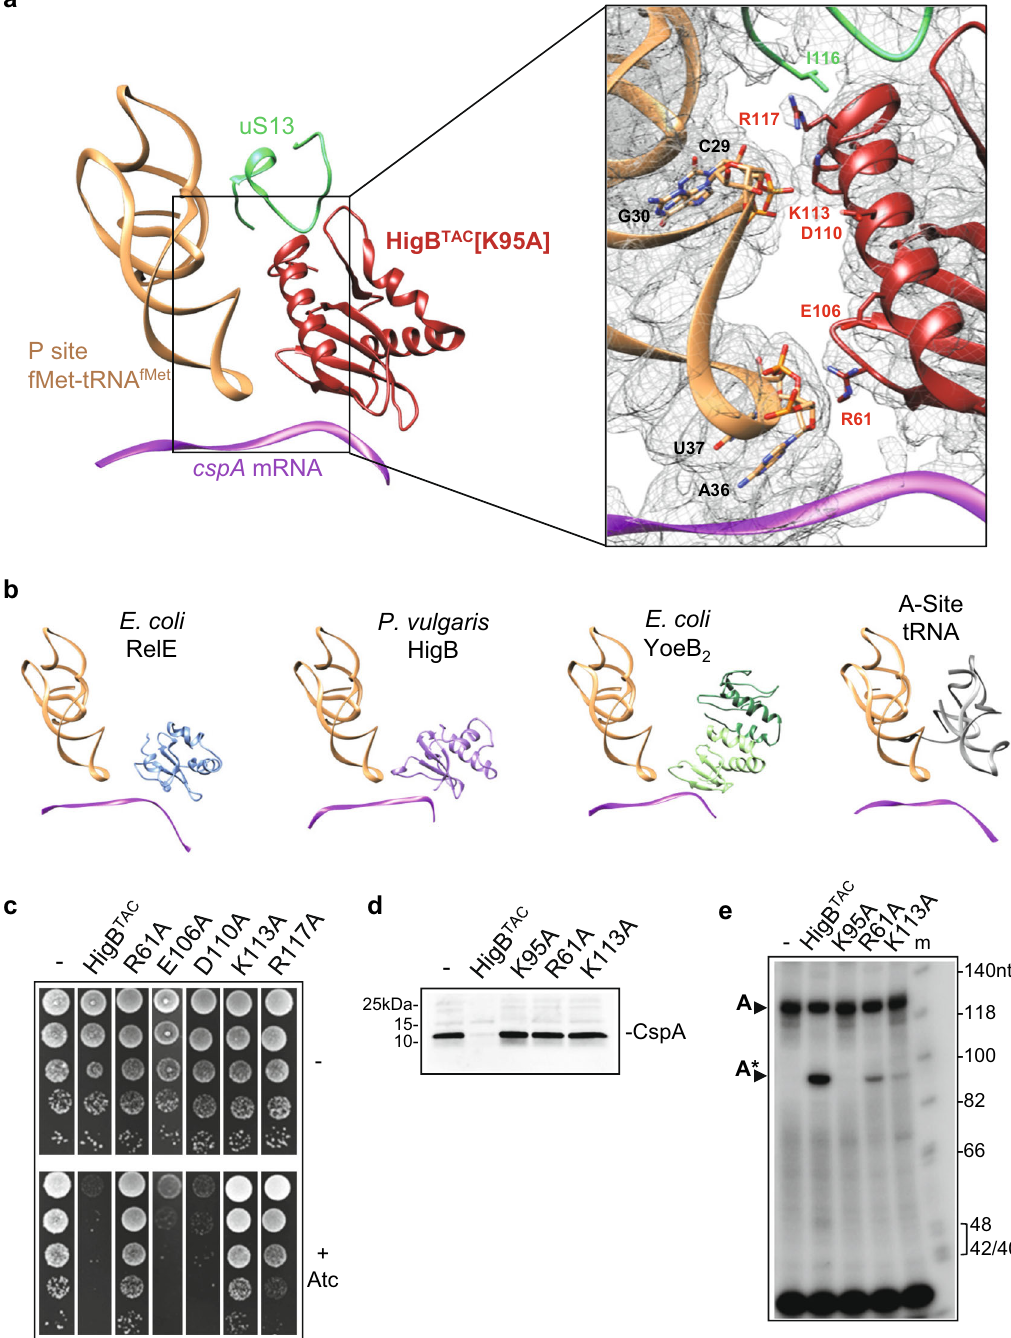
Fig. 6 The C-terminal extension of the TAC toxin interacts with P-site fMet-tRNA fMet and is critical for its function. a Contrary to other ribosome- dependent toxins, HigB TAC strongly interacts with the P-site tRNA and ribosomal protein S13 (uS13). Left, Overview of the contacts between HigB TAC [K95A], the P-site fMet-tRNA fMet , uS13, and the cspA mRNA. Right, Close up of the interactions observed between the third α -helix of HigB TAC [K95A], the P-site fMet- tRNA fMet , and uS13. Residues and nucleotides within 4Å of each other are indicated, and the cryo-electron density map is displayed as a gray mesh. b Known toxins observed in pre-cleavage state with their respective mRNA targets and the P-site tRNA are shown here with a canonical translation reference. The structures are aligned on the P-site tRNA and presented in the same orientation as in a . Shown are (left to right): E. coli RelE [R45A-R81A] (PDB 4V7J); Proteus vulgaris HigB (PDB 4ZSN); E. coli YoeB dimer (PDB 4V8X); and a cognate tRNA observed in the A-site during canonical translation (PDB 7K00). As above, the P-site tRNA is orange and the mRNA is purple. c Positively charged residues of HigB TAC helix α 3 in contact with P-site tRNA are important for its function. M. smegmatis transformed with pGMC-vector (-), HigB TAC wild-type or its mutant derivatives (Alanine substitution of residue R61, E106, D110, K113, or R117) were serial diluted, spotted on LB streptomycin agar plates with or without anhydrotetracycline (Atc ng/mL) inducer and incubated 3 days at 37°C. Alanine substitution in R61 and K113 affects HigB TAC inhibition of CspA synthesis ( d ) and cleavage ( e ) in vitro. CspA was expressed in a cell-free translation system with or without HigB TAC wild-type, R61A, or K113A substitution, and analyzed as described in Fig. 3a for CspA protein synthesis and Fig. 3b for cspA cleavage. HigB TAC [K95A] is shown as inactive control. Arrows show the uncleaved (A, 126 nt) and cleaved (A*, 95 nt) cspA . Representative results of three independent experiments are